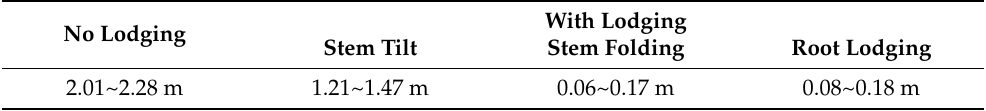
Table 9. The range of canopy height estimated using